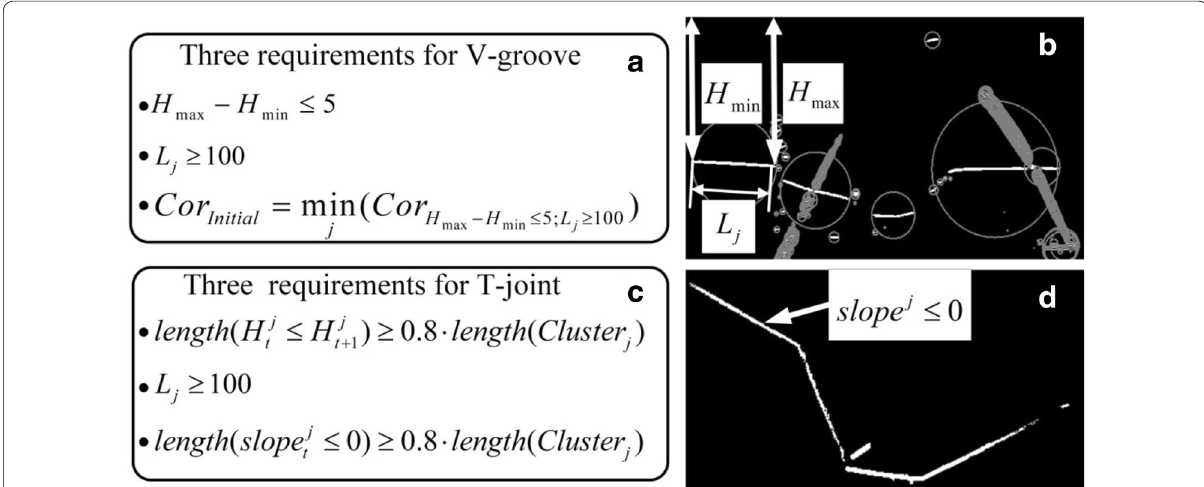
Figure 8 Requirements that are used to determine the first cluster of different WSPs: a three visual requirements for distinguishing the first cluster of the WSP with the V-groove, b illustration of the variables in Figure 8a, c three visual requirements for distinguishing the first cluster of the WSP with the T-joint, d illustration of the requirement of the slope for the first cluster of the WSP with the T-joint